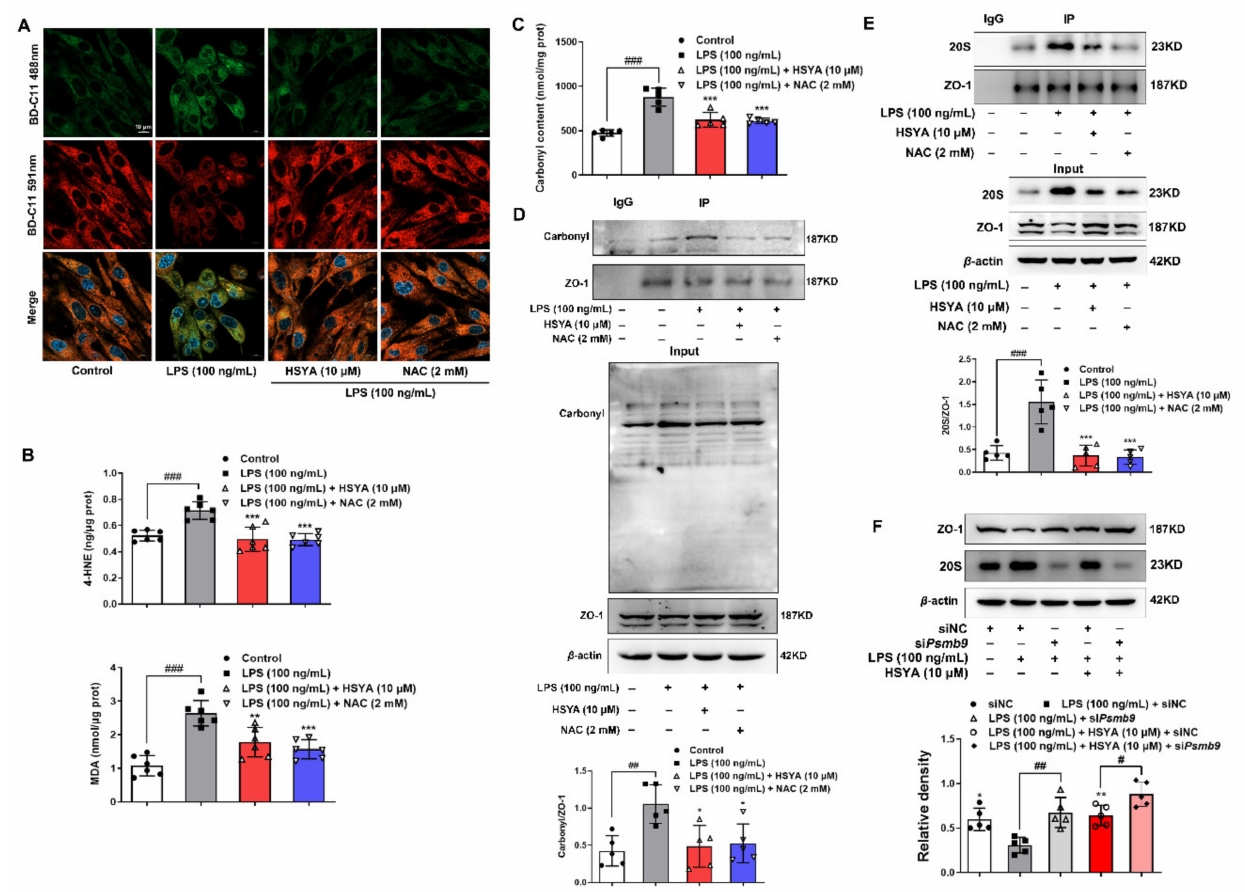
Figure 5. HSYA protected ZO-1 protein stability from 20S proteasome degradation: ( A ) the level of lipid peroxidation was observed, in which reducing lipid was in red and lipid peroxidation was in green (scale bar: 10 µ m); ( B , C ) the concentration of 4-hydroxynonenal (4-HNE) and malondialdehyde (MDA) and the carbonyl content in LPS-induced bEnd.3 cells; ( D ) the carbonylation level of ZO-1 was determined by immunoprecipitation; ( E ) the immunoprecipitation assay of the binding of 20S to ZO-1 in bEnd.3 cells; ( F ) bEnd.3 cells were treated with HSYA in the presence of LPS when transfected with 20S siRNA (si Psmb9 ) or control siRNA (siNC). Protein expression of ZO-1 was determined ( n = 5 in each group). All data are presented as mean ± SD of five independent experiments. # p < 0.05, ## p < 0.01, ### p < 0.001 vs. indicated group, * p < 0.05, ** p < 0.01, *** p < 0.001 vs. LPS